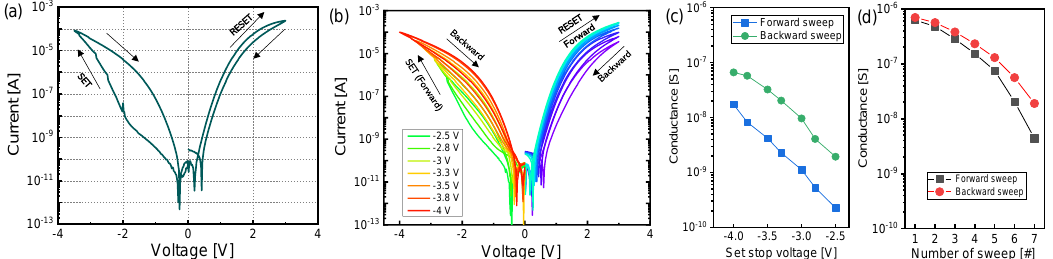
Figure 2. Current-voltage (I–V) curves and multilevel conductance characteristics of TiN/Ti/TiO 2 /SiO x /Si device: ( a ) typical I–V curves; ( b ) current change characteristics by repeated sweep from −2.5 to −4 V for set process and fixed 3 V for reset process; ( c ) conductance gradually increases with incremental set stop voltage; ( d ) conductance gradually decreases using the same voltage sweep (3 V).